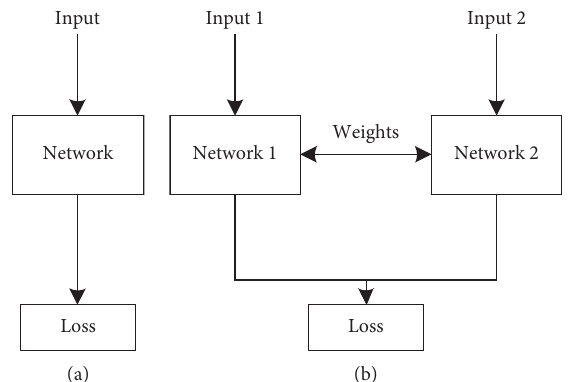
Figure 2: (a) Current existing of DL network architecture used in DL-based VO. (b) Siamese network architecture used in our paper with weight sharing.